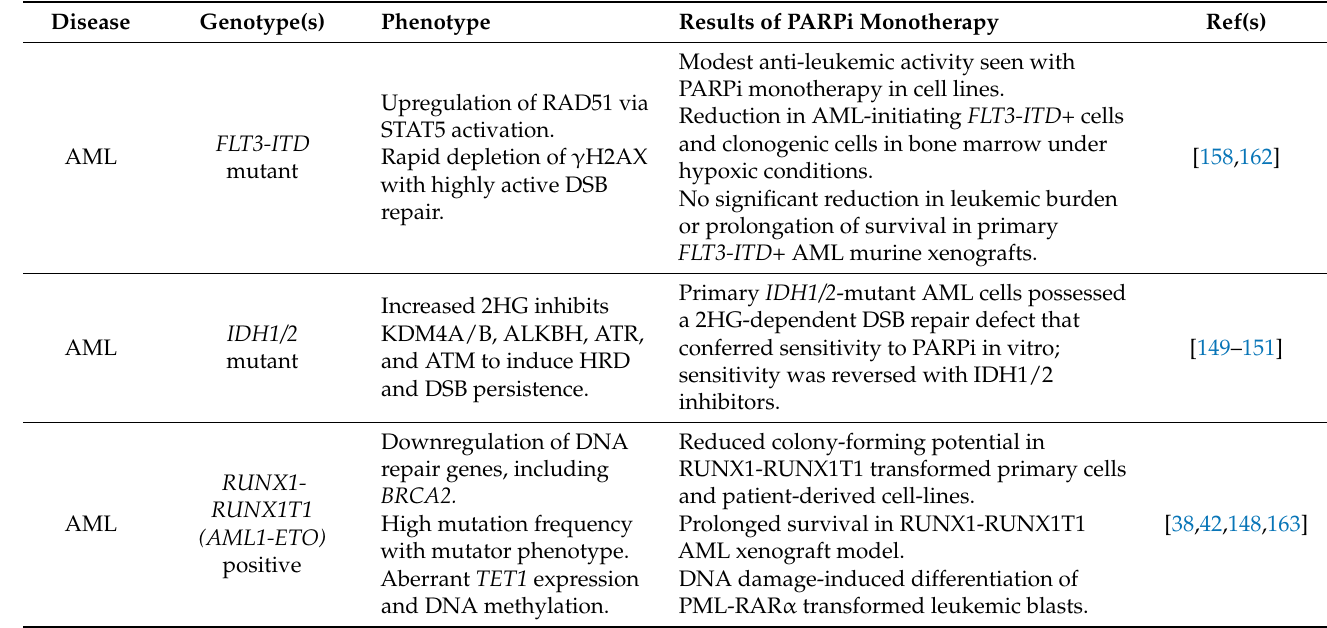
Table 1. Preclinical Results of PARP Inhibitor Monotherapy in Defined Molecular Subtypes of Myeloid Neoplasms.